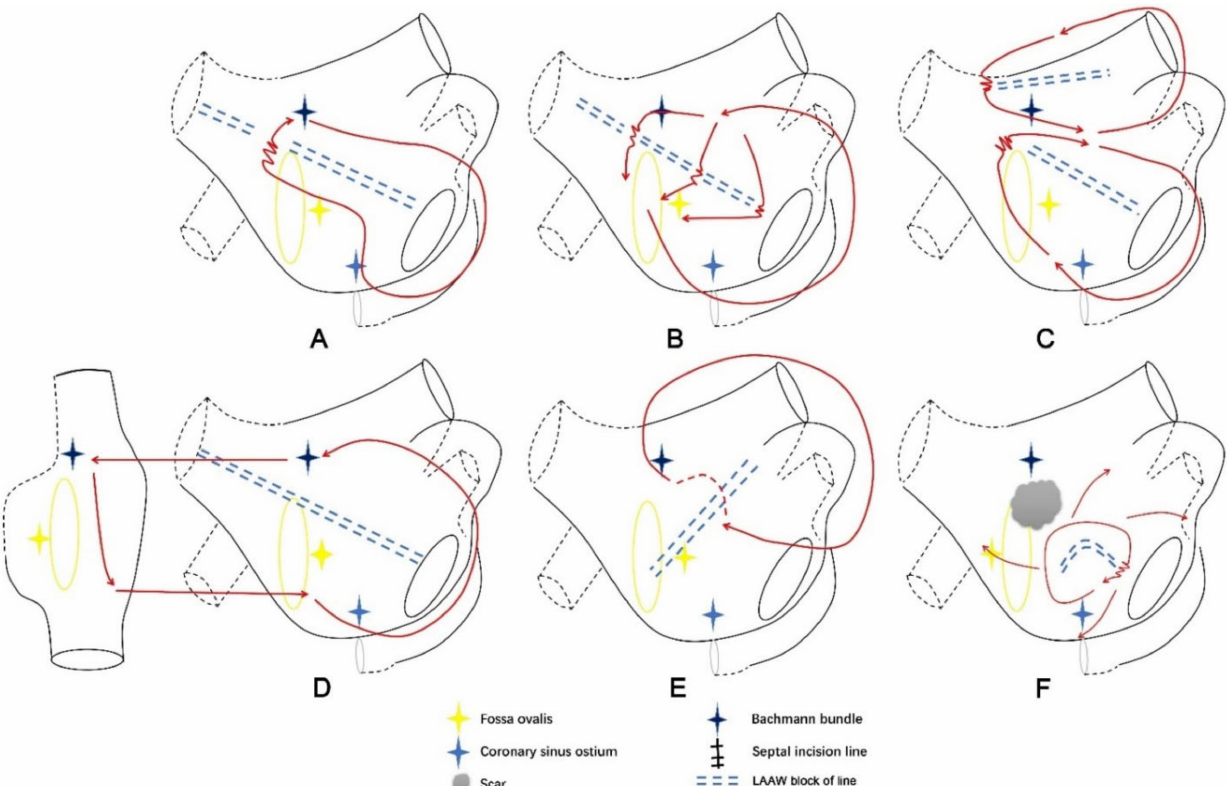
Figure 1. Simplified schemas of six subtypes of the left atrial anterior wall (LAAW) atrial tachycardia (AT) reentrant circuits. ( A ), Type 1.1: Single-looped macro-reentrant AT with one single LAAW gap as the critical area. The propagation of AT ran across the LAAW gap and around the mitral valve annulus (MVA). ( B ), Type 1.2: The propagation course was similar to Type 1.1, except that there were multiple LAAW gaps. The propagation of AT ran around the MVA and went across all the LAAW gaps. ( C ), Type 1.3: Dual-looped AT with LAAW conduction gap(s) as the critical area. The wavefront simultaneously propagated around a pre-existing LA roof scar and ran around the LAAW scar and MVA. ( D ), Type 2.1: Single-looped bi-atrial reentrant ATs whose circuit used both LA and RA. The wavefront activated RA at the superior septum consistent with RA insertion of BB, running down the septum and jumped to LA through fossa ovalis or coronary sinus ostium. Then the wavefront ran around the MVA counterclockwise to LAAW, returning to the LA insertion of BB to complete the circuit. ( E ), Type 2.2: LAAW epicardial macro-reentrant AT featured by an epicardial connection crossing the pre-existing linear lesion. The wavefront began at the LAAW breakthrough above the lesion line, ran around LA roof then down along LA posterior wall, and then went around LA lateral wall and across the lesion line via the epicardial connection. ( F ), Type 3: LAAW micro-reentrant AT. The circuit ran around a minor LAAW block of line near the MVA, and the wavefront of AT propagated in a centrifugal pattern. The red line with arrows indicated the circuit of AT; the jagged line indicated the wavefront passing the slow conduction area; the red dashed line indicated the epicardial bypass of the AT